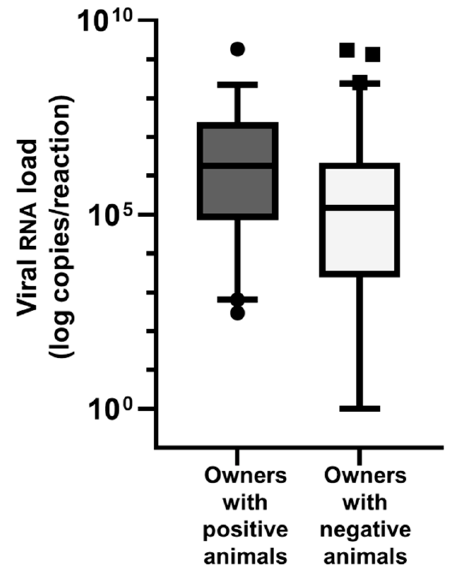
Figure 4. Relationship between the viral RNA load of samples from people and the positivity status of animals in the same household. A mean copy number value was calculated for each sample from the RT-qPCR results of the E-assay and the RdRp-assay. Box and whiskers plot: boxes extend from 25% to 75%, whiskers from 5% to 95%. Owners with SARS-CoV-2 positive animals had significantly higher viral RNA loads than owners with SARS-CoV-2 negative animals ( p = 0.0085).